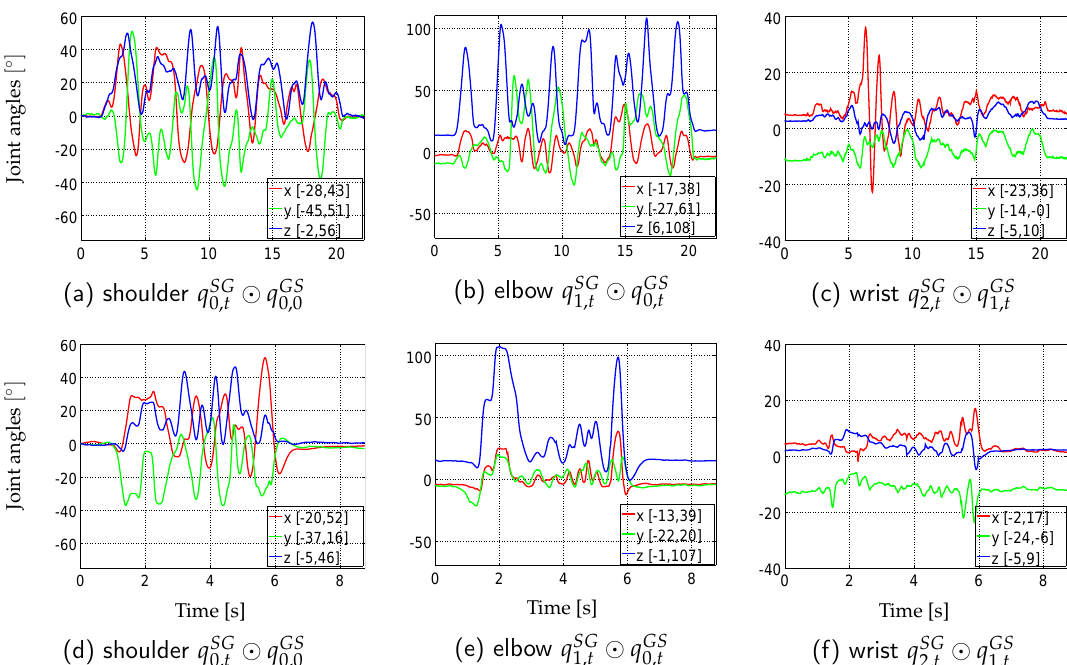
Figure 3. Real data scenario: Euler angle sequences ( z , x (cid:48) , y (cid:48)(cid:48) convention) and ranges of motion, [ minimum angle,maximum angle ] (each provided in degree), of real-slow ( a – c ) and real-fast ( d – f ). The segment axes and initial segment orientations are as shown in Figure 2. Note, the shoulder angles (left column) are represented w.r.t. to the initial upper arm configuration q GS global frame, in order to cancel out the unknown heading offset for easier interpretation.